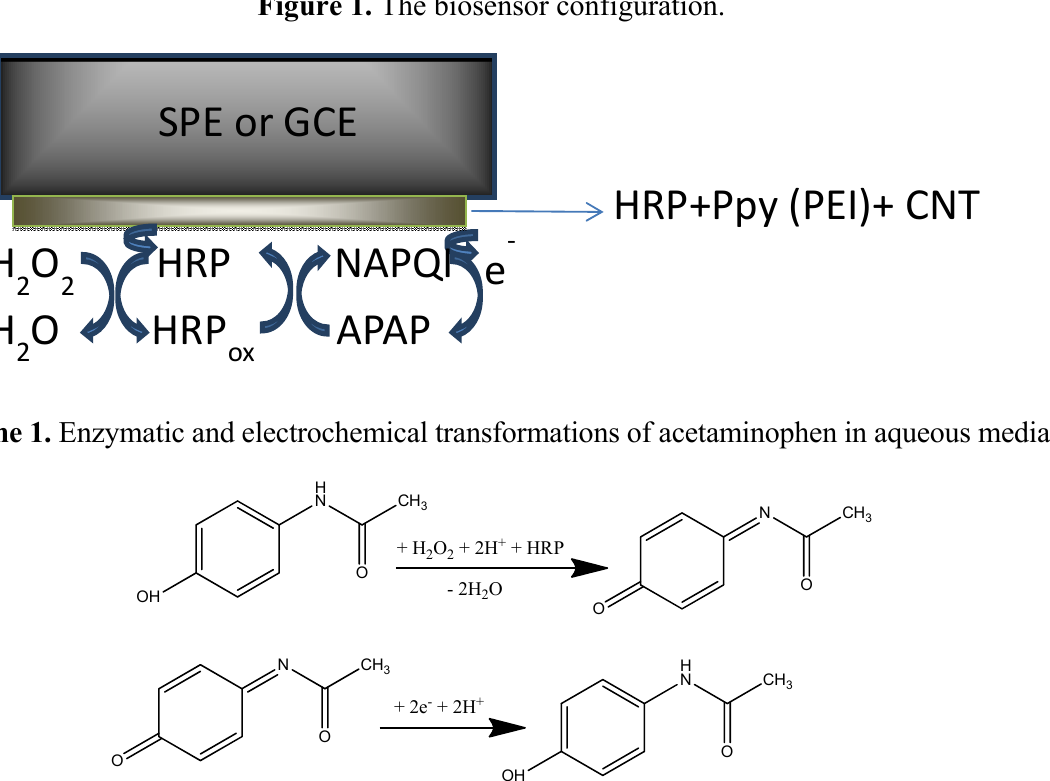
Figure 1. The biosensor